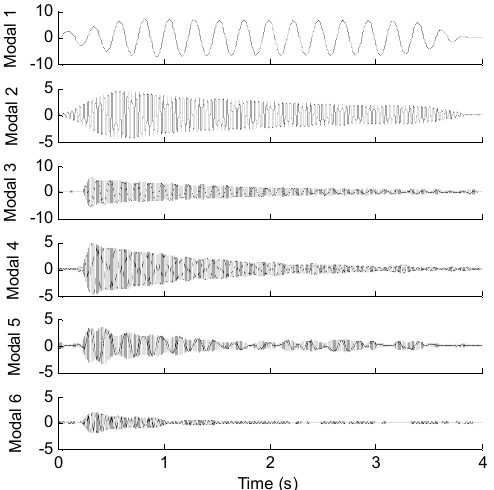
Figure 19. Modal strain responses of the 15-th optical fiber measurement data obtained by EMD method with intermittency criteria.